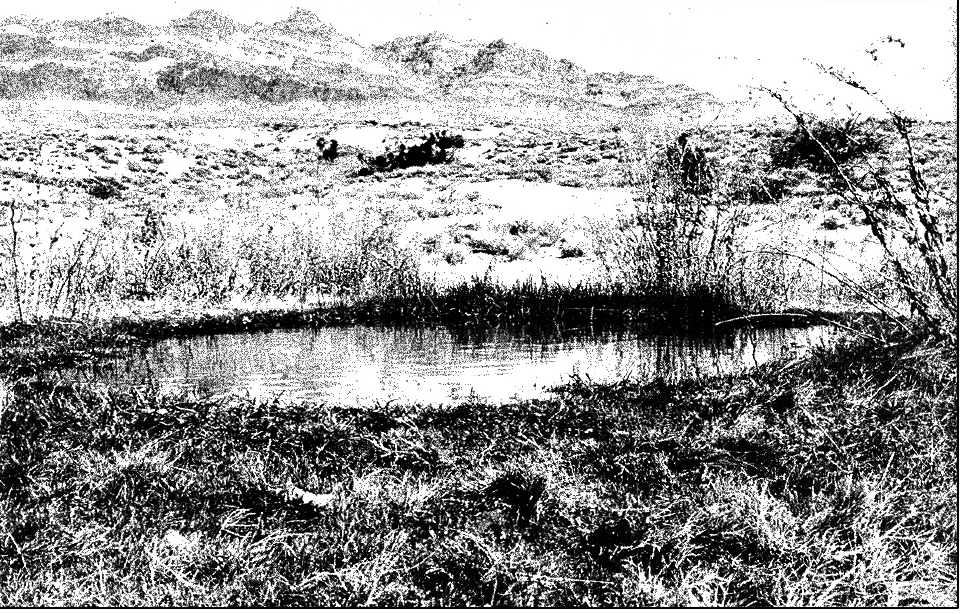
Figure 23. Corn Creek Spring with active flow in 1967 [76].